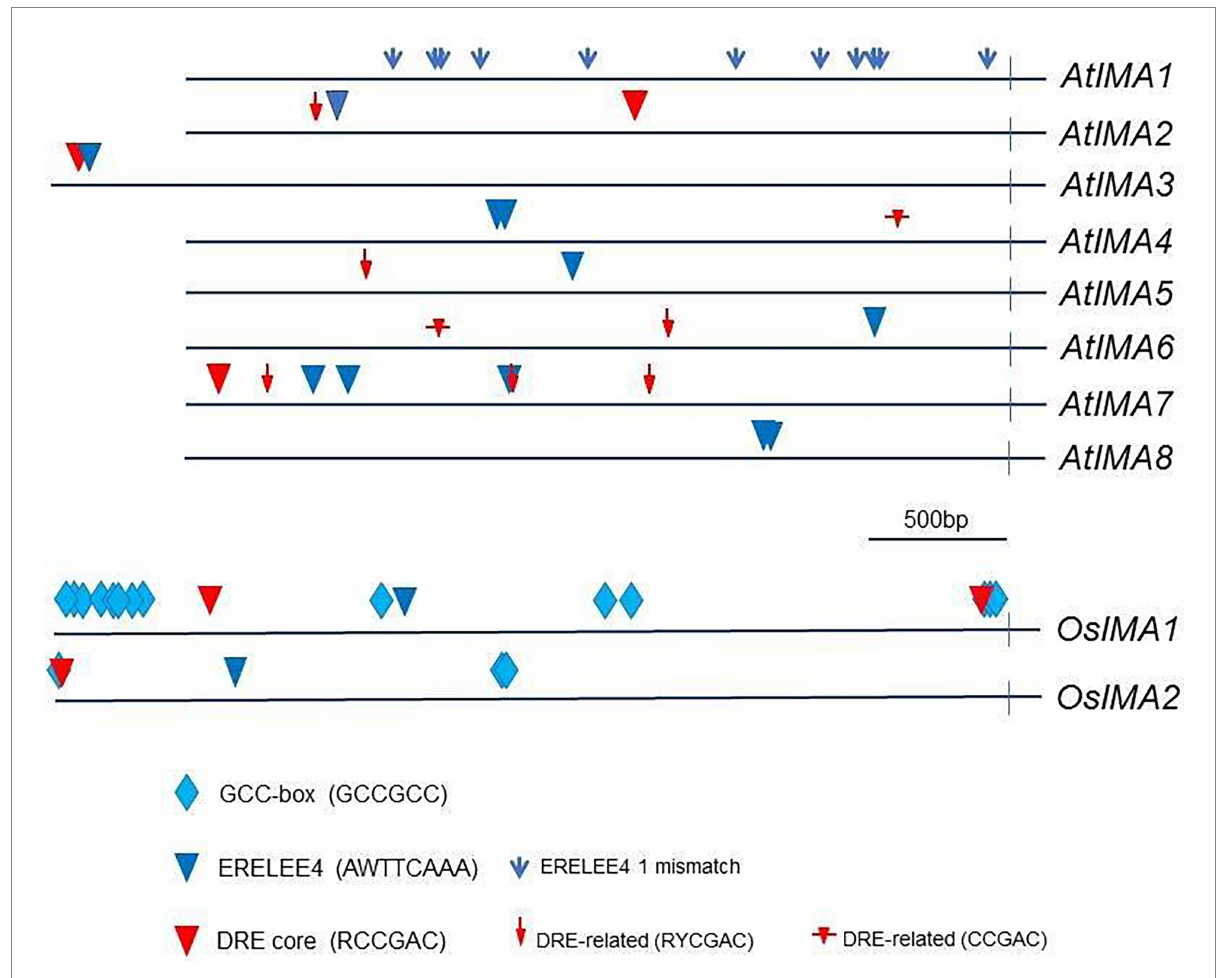
FIGURE 7 Location of ethylene-responsive motifs in the promoter regions of IMA genes. Ethylene-responsive motifs in the promoters of IMA genes were located by using the PLACE (Plant Cis-acting Regulatory DNA Elements) database. A stretch of 3,000 bp upstream of the transcription initiation site was examined in Arabidopsis ( AtIMA ) and in rice ( OsIMA ) sequences. For AtIMA3 and OsIMA1 and OsIMA2 , the surveyed stretch was extended to 4,000 bp. The sequences of the promoter regions of the IMA genes were obtained from the EnsemblPlant and the TAIR database. AtIMA1 (AT1G47400), AtIMA2 (AT1G47395), AtIMA3 (AT2G30766), AtIMA4 (AT1G07367), AtIMA5 (AT1G09505), AtIMA6 (AT1G07373), AtIMA7 (AT2G00920), AtIMA8 (AT1G47401), OsIMA1 (Os01g0647200), OsIMA2